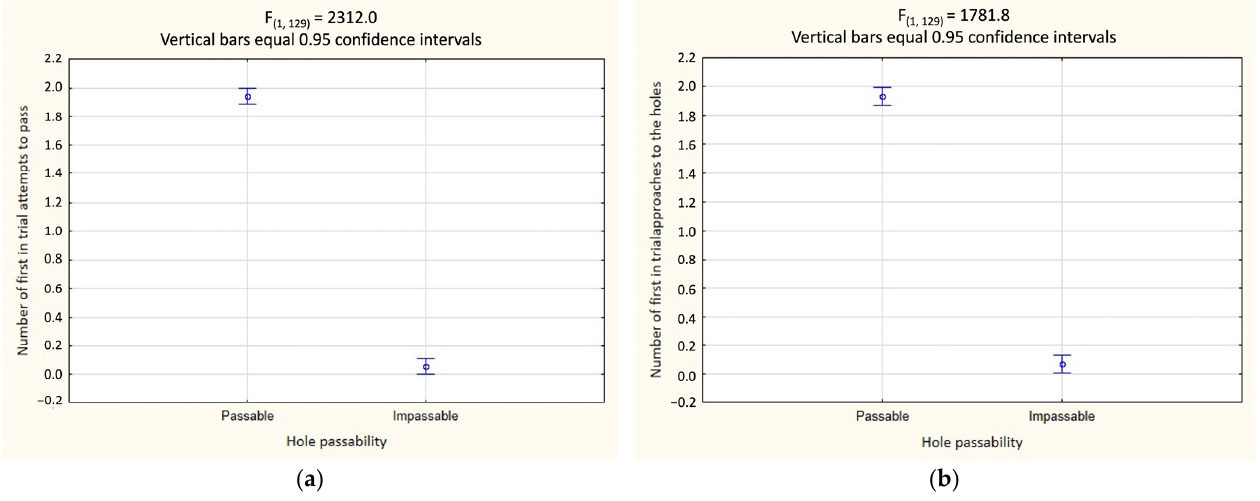
Figure 6. Experiment 2 ( n = 6): ( a ) differences in the average number of first penetration attempts on the holes as a function of their passability/impassability; ( b ) differences in the average number of first approaches in relation to holes in a trial depending on their passability/impassability.